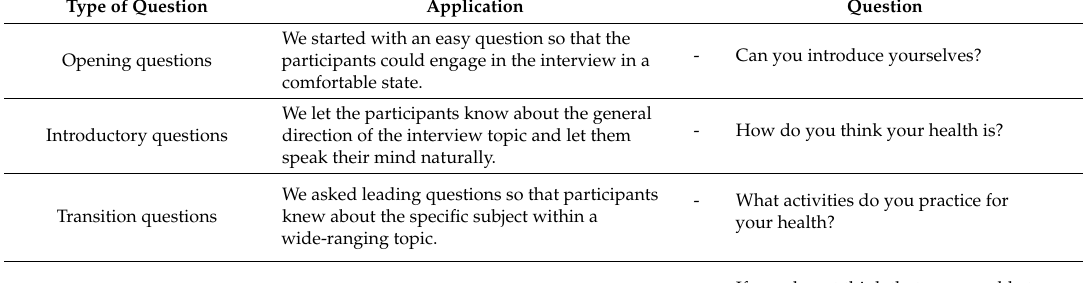
Table 1. Focus group interview